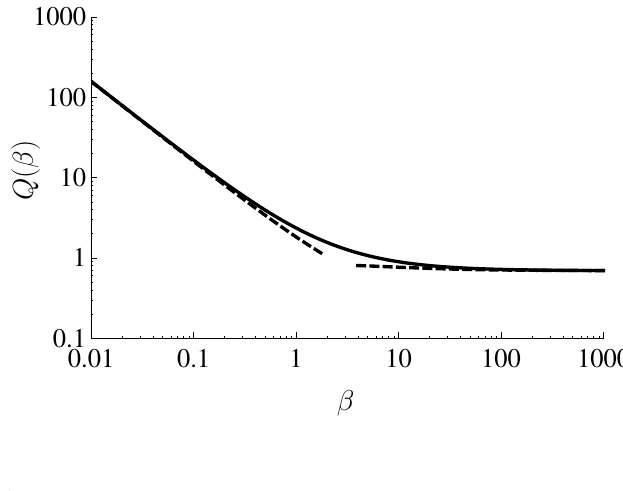
Figure 3. Log-log plot of the function Q ( β ) . The solid line has been calculated numerically as described in Section 2.2, and the dashed lines have been plotted using the asymptotic expressions given by Equation (62) for β (cid:28) 1 , and Equation (63) for β (cid:29) 1